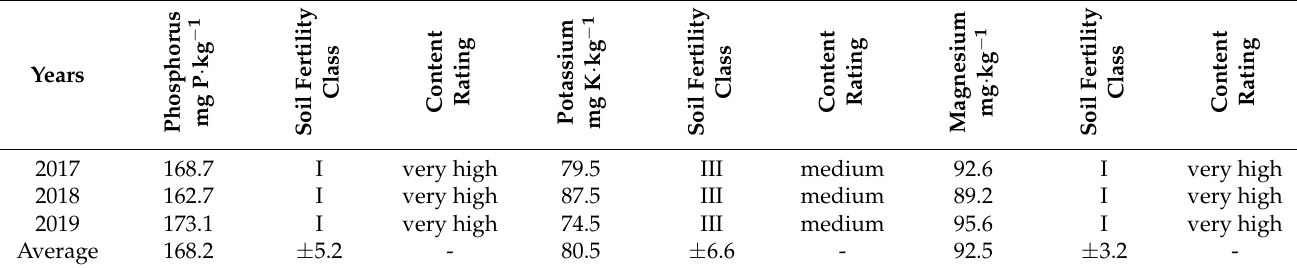
Table 2. Macronutrient soil content in the growing seasons adapted from [7].